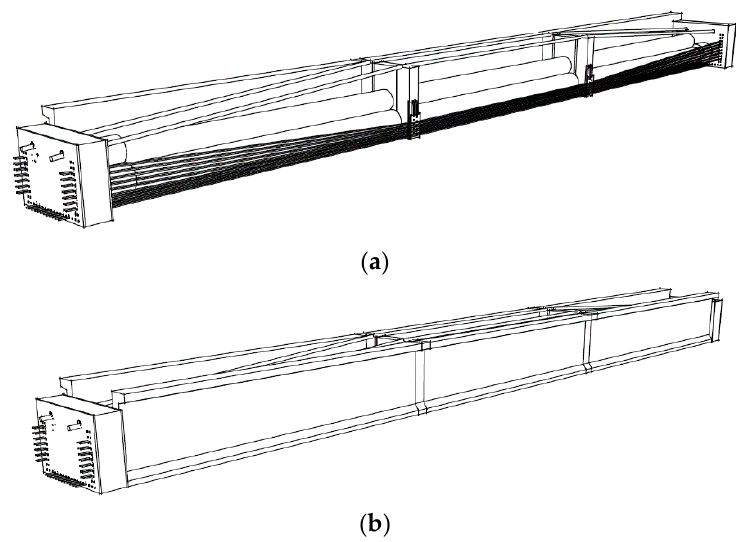
Figure 2. Pre-tensioning mechanism using internally placed concrete piles as a reaction arm and forces applied through strands to anchor blocks for ( a ) Arrangement of anchor block-hydraulic cylinder-internal reaction arm ( b ) After concrete pouring and curing.